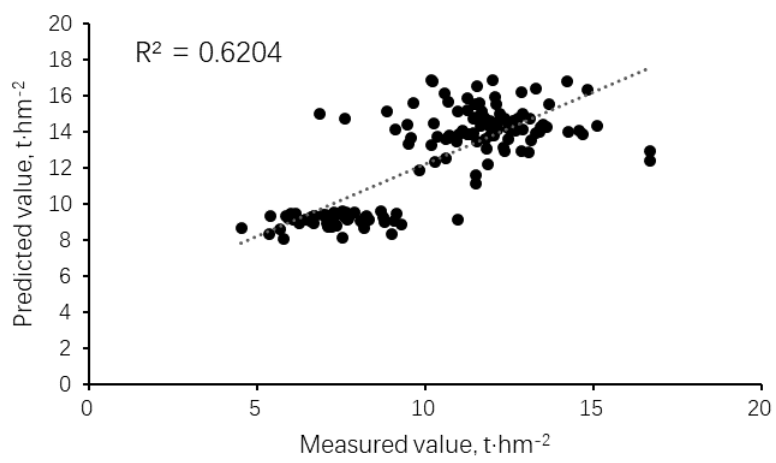
Figure 5. Comparison chart of predicted yield and actual